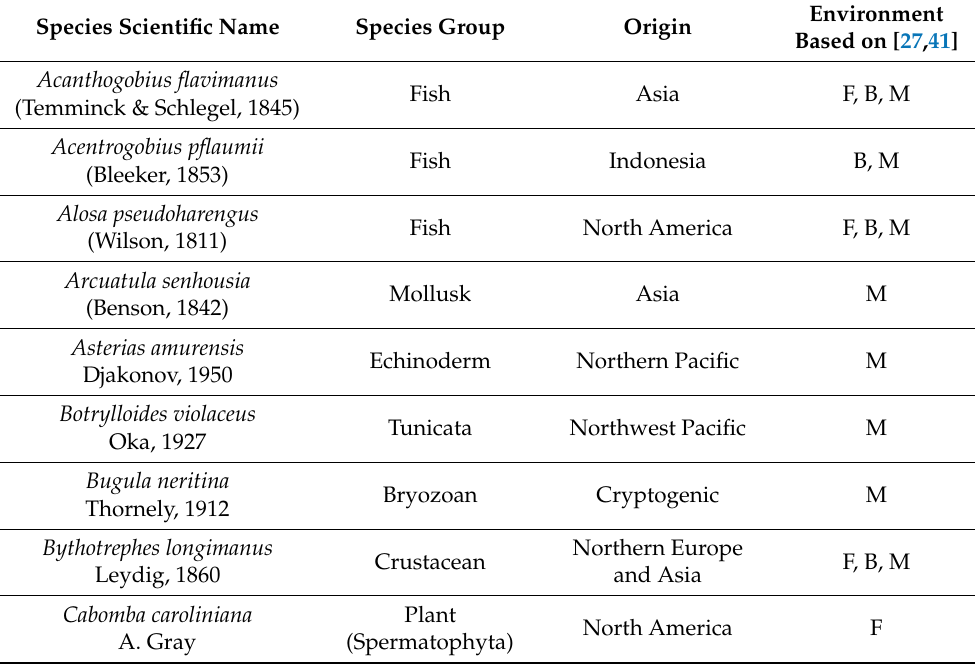
Table 3. List of potential IAS in the Baltic Sea introduced by